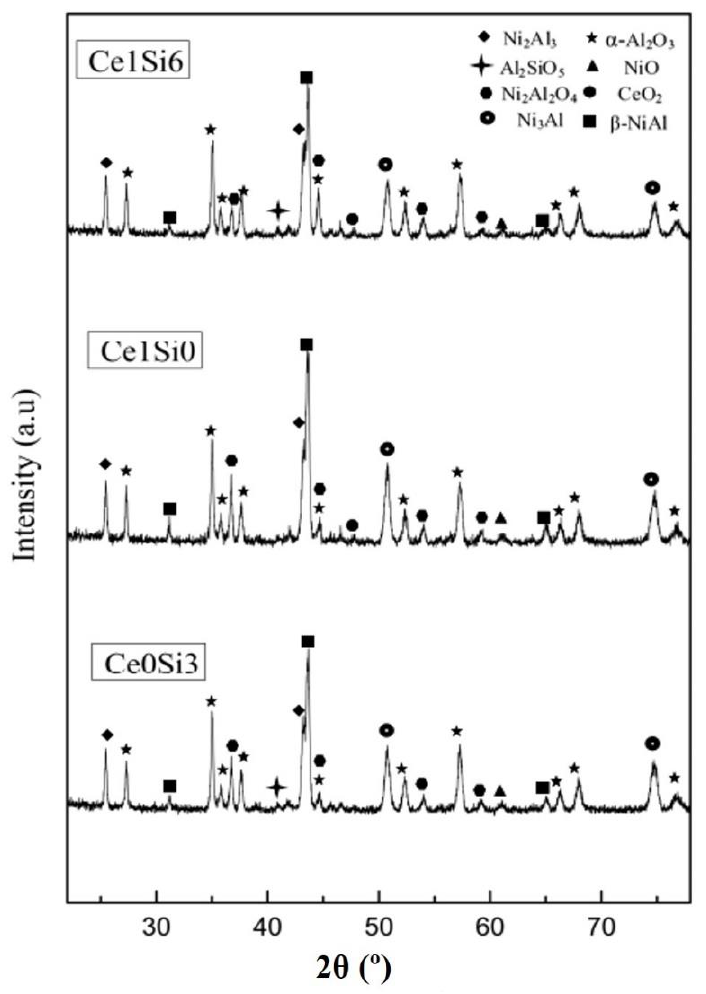
Figure 7. X-ray diffraction of coated samples after 50 cycles of oxidation tests at 1100 °C.